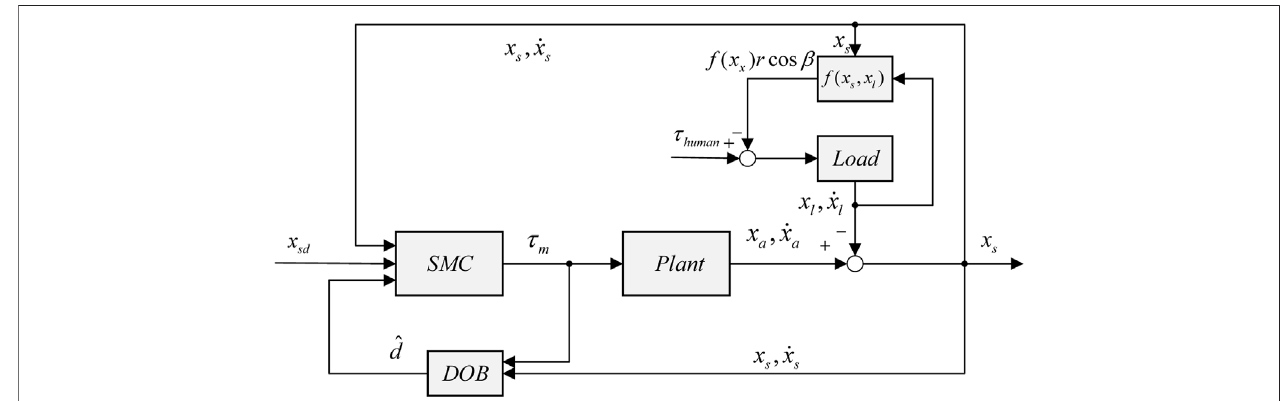
FIGURE 4 | Zero-impedance control block